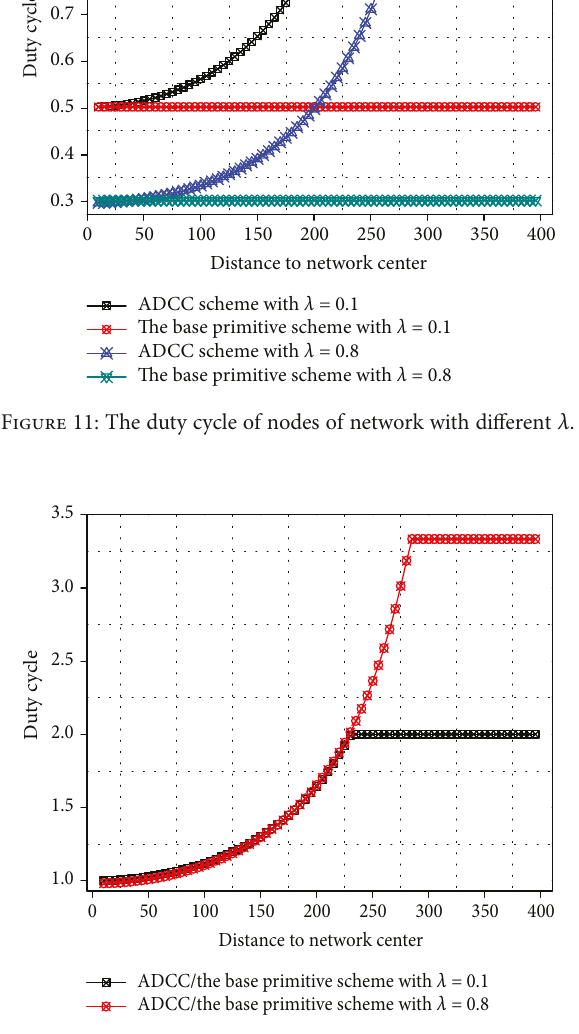
Figure 12: The ratio of duty cycle of nodes of networks with di ff erent